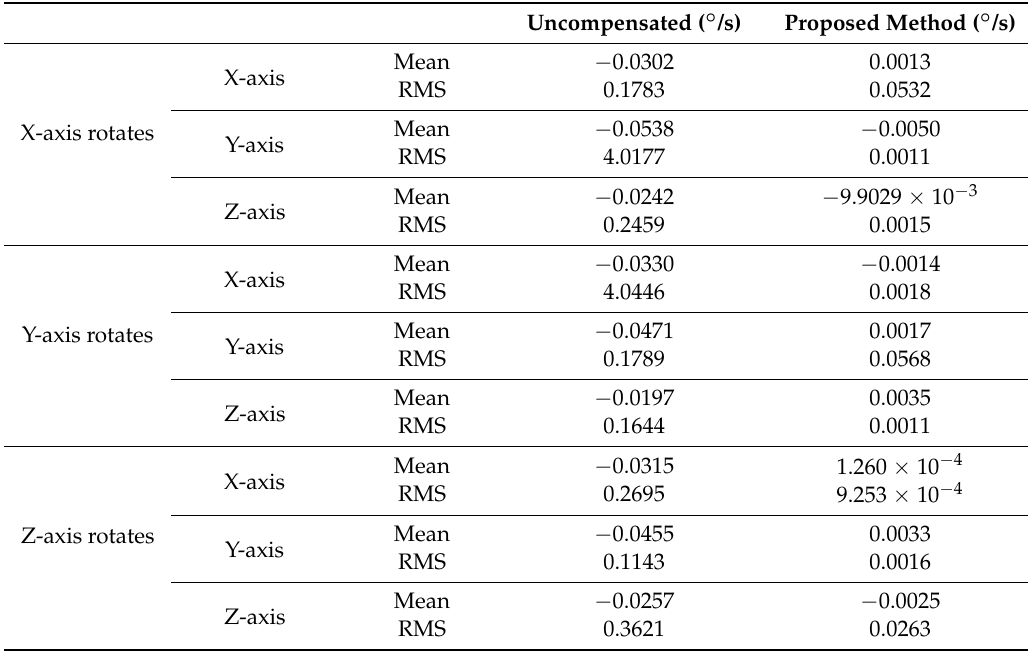
Table 3. Comparison of the Mean and Root Mean Square (RMS) (uncompensated method and the proposed